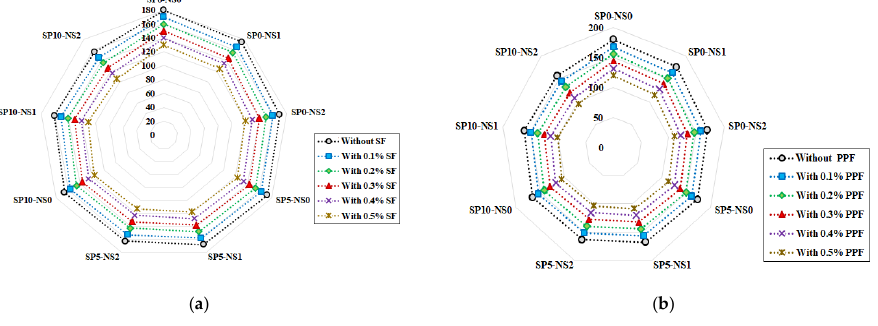
Figure 6. Impact of the fibres on the slump of HSC ( a ) SF and ( b ) PPF. In SF reinforced HSC, a reduction trend occurred by raising the content of SN and SP. A similar tendency was observed in PPF reinforced HSC manufactured with NS and SP (Figure 7). By comparing Figure 7a,b, a greater impact of PPF on slump reduction is observed due to higher water demand and absorption of polymer fires (PPF in this study), in comparison with SF [32].